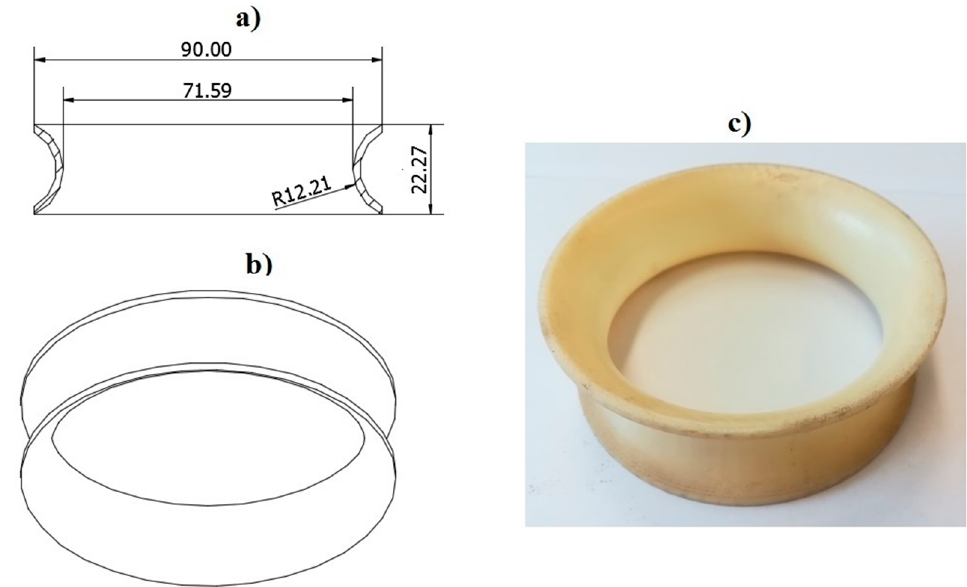
Figure 2. An innovative distributor of the seed-and-air stream in a pneumatic seed drill: ( a ) cross- sectional view of the stream diffuser with basic dimensions, ( b ) bottom view of the CAD 3D model, ( c ) top view of the CAD 3D model, ( d ) view of the stream diffuser prototype made with the rapid prototyping method.